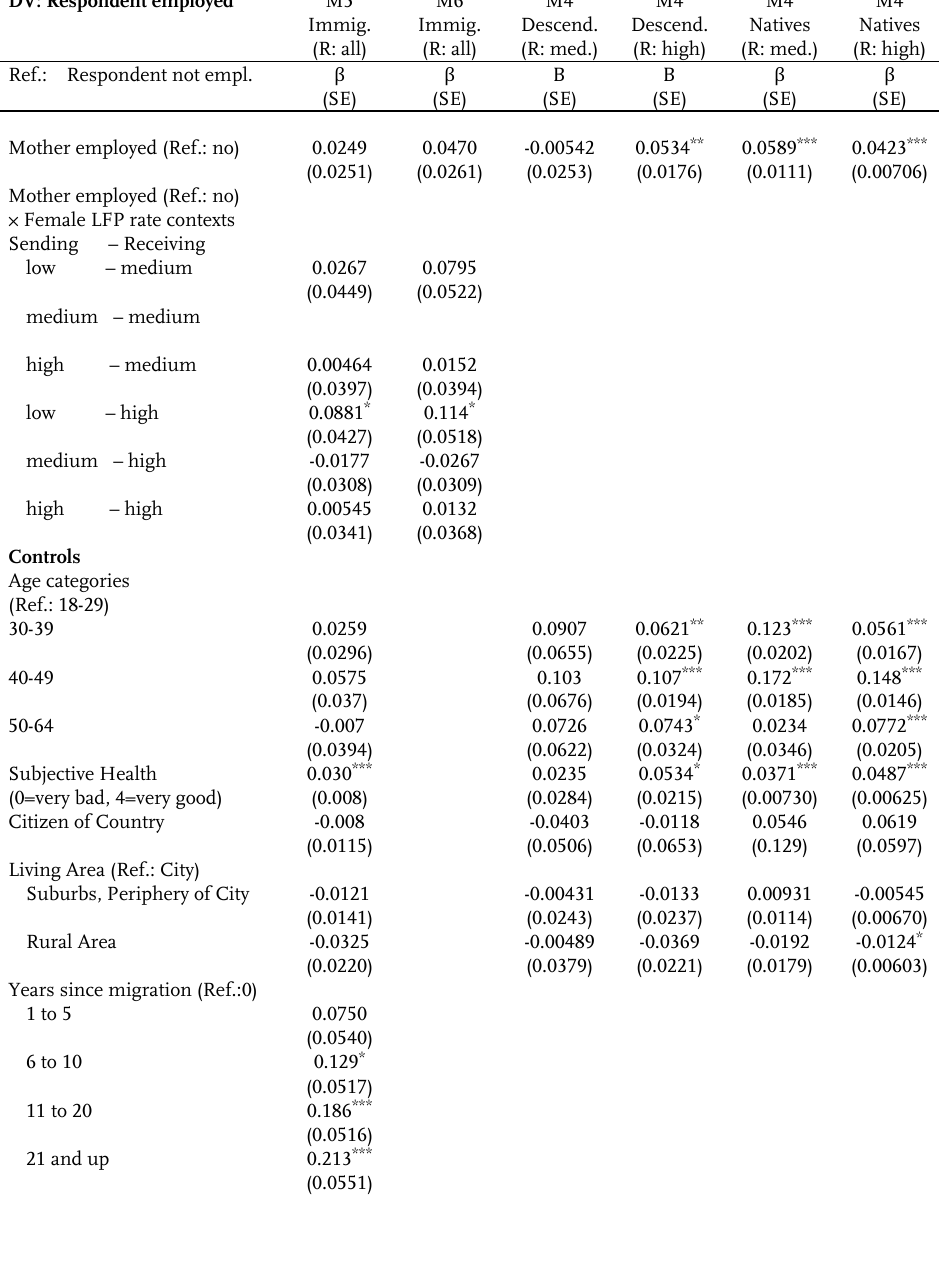
Table A.5 : Full models M5 and M6 for immigrants, M4 for descendants and natives